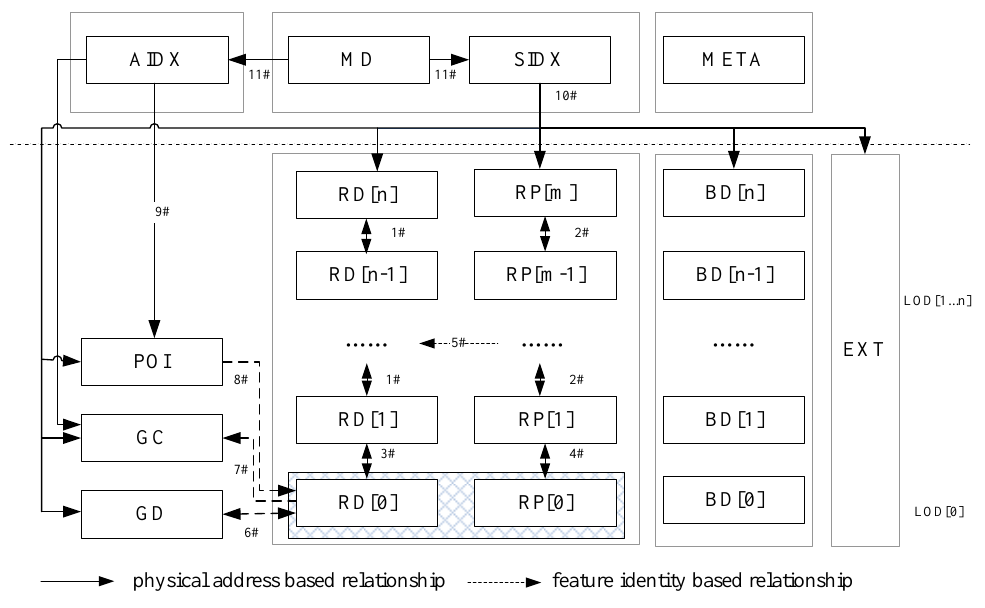
Figure 2. Logical structure of the China Navigation Data Format (CNDF).